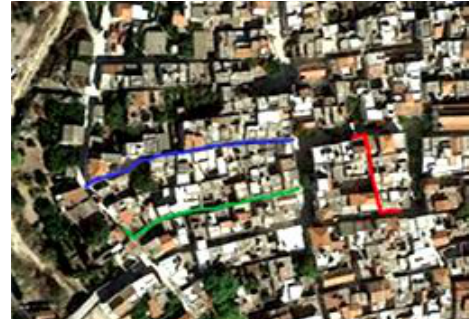
Figure 6: Documented streets (Image by Google Maps)